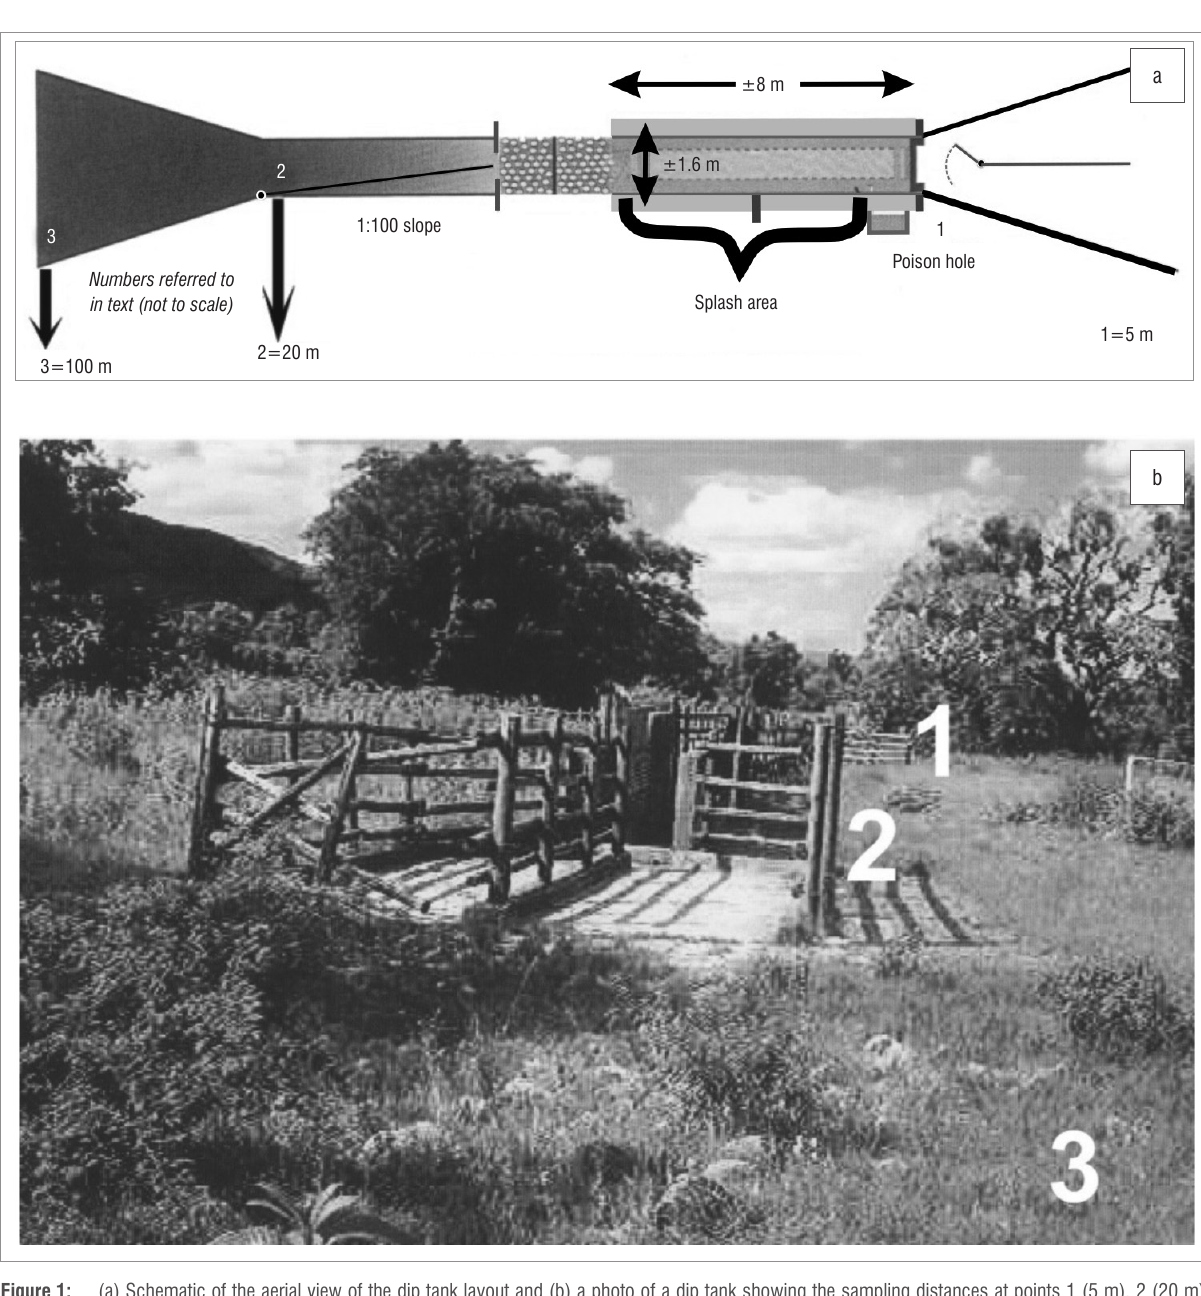
Figure 1: (a) Schematic of the aerial view of the dip tank layout and (b) a photo of a dip tank showing the sampling distances at points 1 (5 m), 2 (20 m) and 3 (100 Absolute concentration of arsenic residues Surface soil around the 10 dip sites depicted enhanced arsenic values (Table 2), which ranged from 0.001 mg/kg to 46.76 mg/kg at a 5-m distance from the tanks (Figure 2). Sambandou had the highest mean concentration (18.24 mg/kg) and Tshandama the lowest (0.002 mg/kg). Five of the 10 dip sites (Khubvi, Rambuda, Sambandou, Tshifudi and Tshivhulani) displayed moderate to high concentrations (>3 mg/kg) of arsenic residues at the 5-m distance.